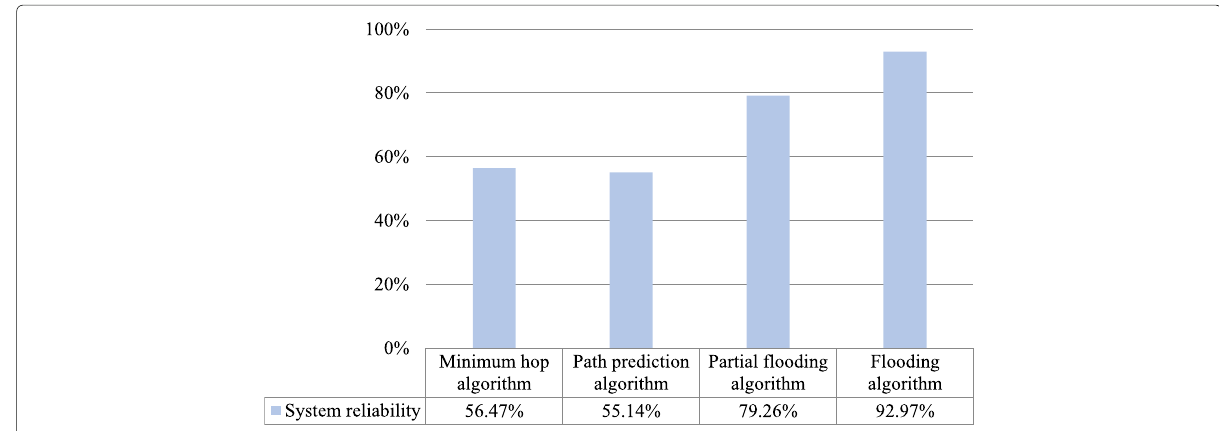
Fig. 8 Comparison of system reliability of different offloading